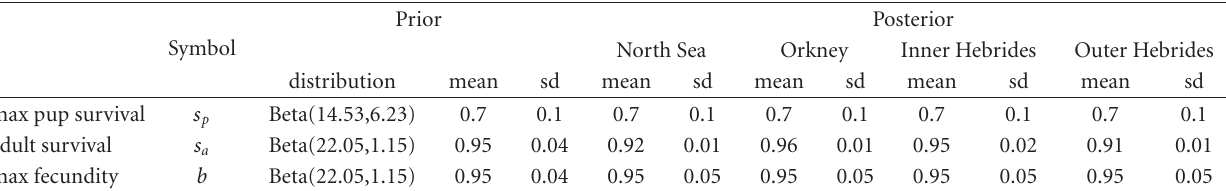
Figure 1: Grey seal pup production estimates (points) and smoothed estimates (with 95% credibility intervals) for each of the four regions. Table 1: Distributions of parameter values. The priors are taken from Newman et al. [9], the posterior values are those from the replicate model runs in each